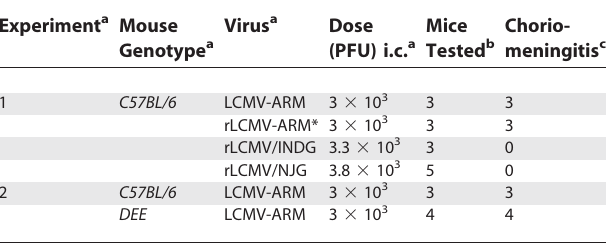
Table 1. The Viral GP Determines Pathogenicity of Engineered LCM Viruses in i.c. Infected Mice